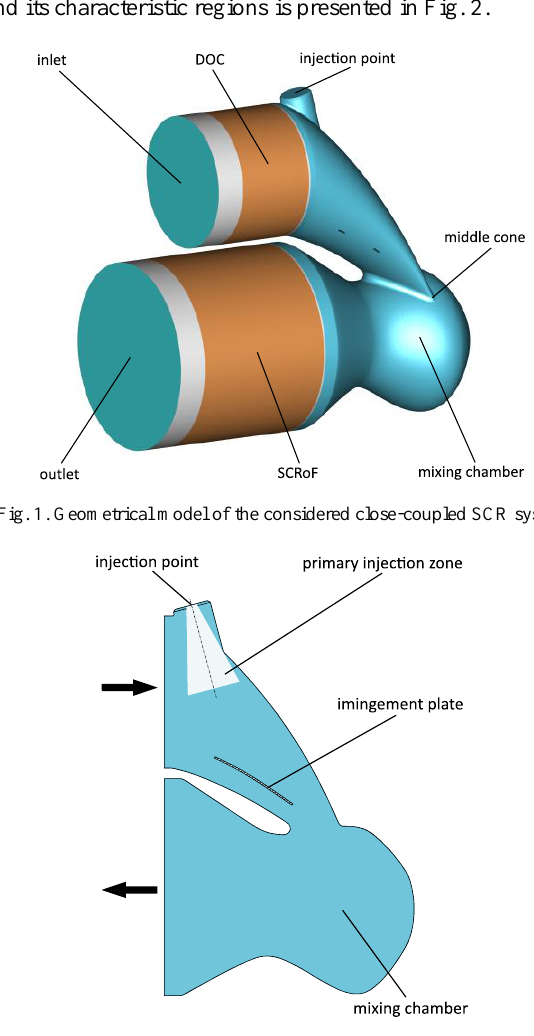
Fig. 2. Section view of the middle